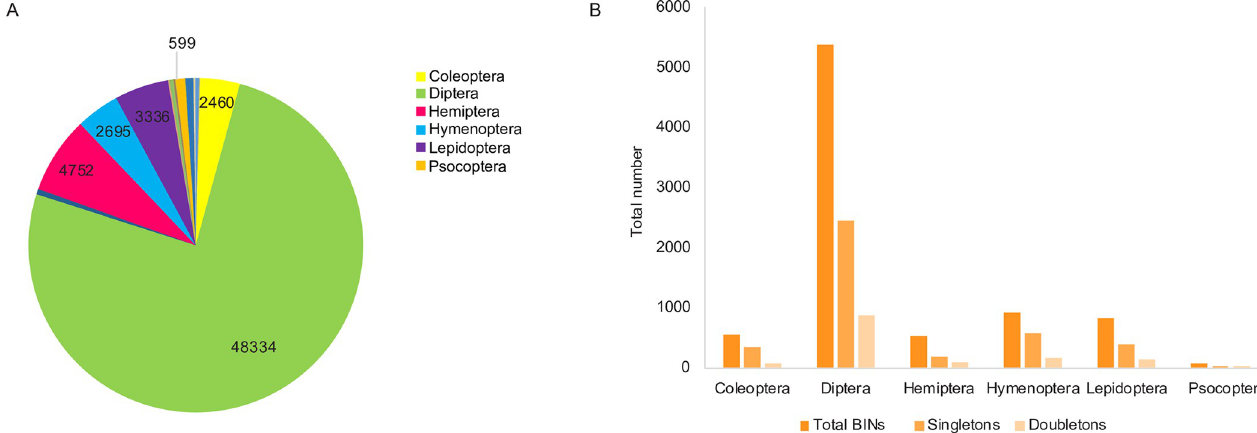
Fig 2. Abundance and richness of the most common orders. (A) Total abundance of each order, detailing the values of the six most common orders; (B) number of total BINs, singletons and doubletons for the six most common orders.